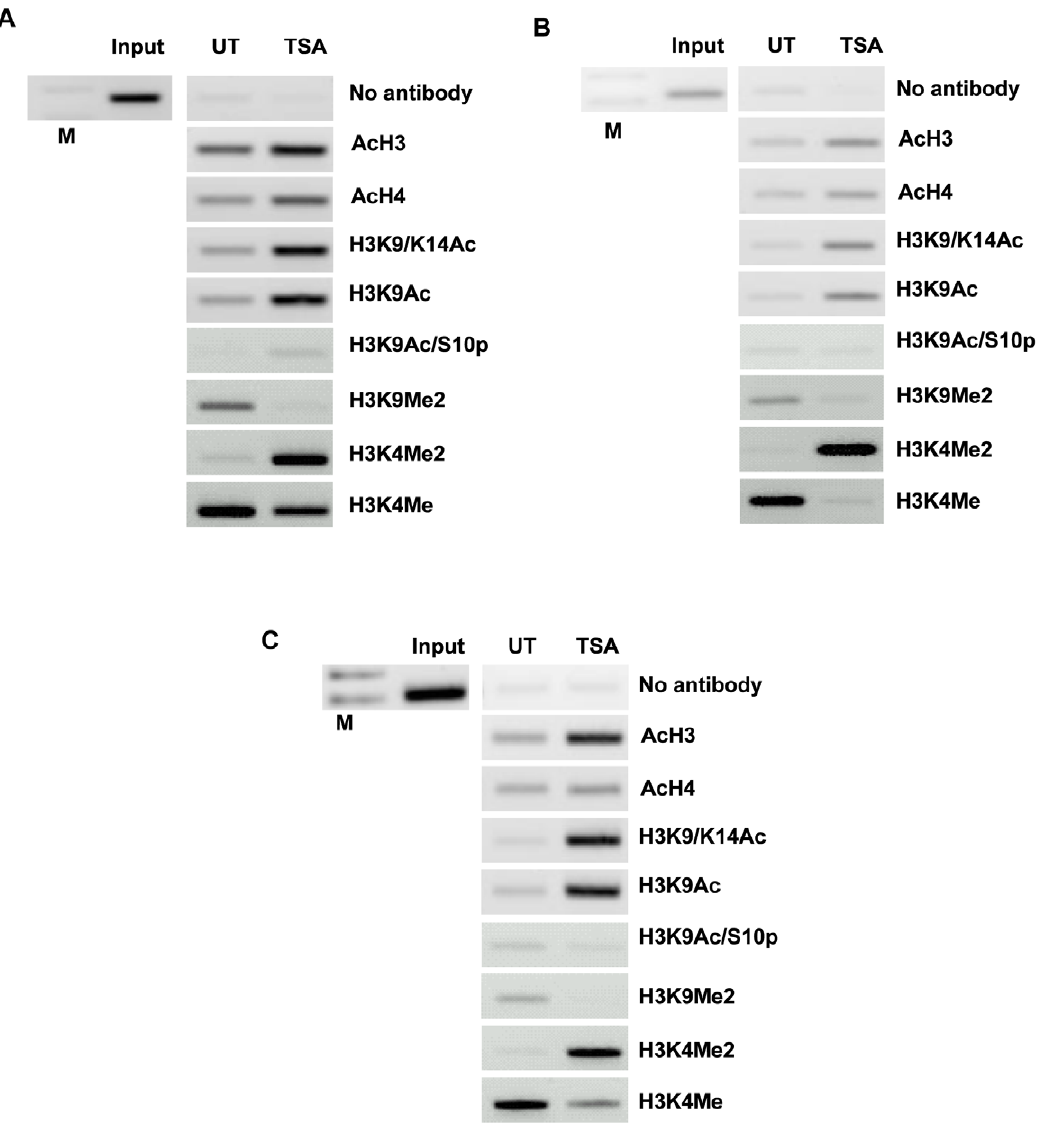
Figure 4. Histone acetylation occurs directly at the promoter regions of CXCL8 and CXCR1/2 . The ChIP assay demonstrates that TSA treatment results in an increase in the acetylation of histone H3 and H4. A549 cells were cultured in the presence or absence of TSA (250 ng/mL) for a period of 16 h. Subsequently, a ChIP assay was performed using the following antibodies; pan acetylated histone H3 (Ac H3) and H4 (Ac H4), histone H3 acetylated at lysine 9 and 14 (H3K9/K14Ac), histone H3 acetylated at lysine 9 (H3K9Ac), histone H3 acetylated at lysine 9 and phosphorylated at serine 10 (H3K9pS10), Histone H3 dimetylation marker at lysine 9 (H3K9Me2), dimetylation marker at lysine 4 (H3K4Me2) and methylation marker at lysine 4 (H3K4Me). The chromatin status at the promoter region of (A) CXCL8 , (B) CXCR1 and (C) CXCR2 is shown. Input DNA serves as a positive control recommended by the manufacturer (Diagenode). A no antibody control was included to test for non specific carriage of DNA with histones. (M – DNA size ladder).